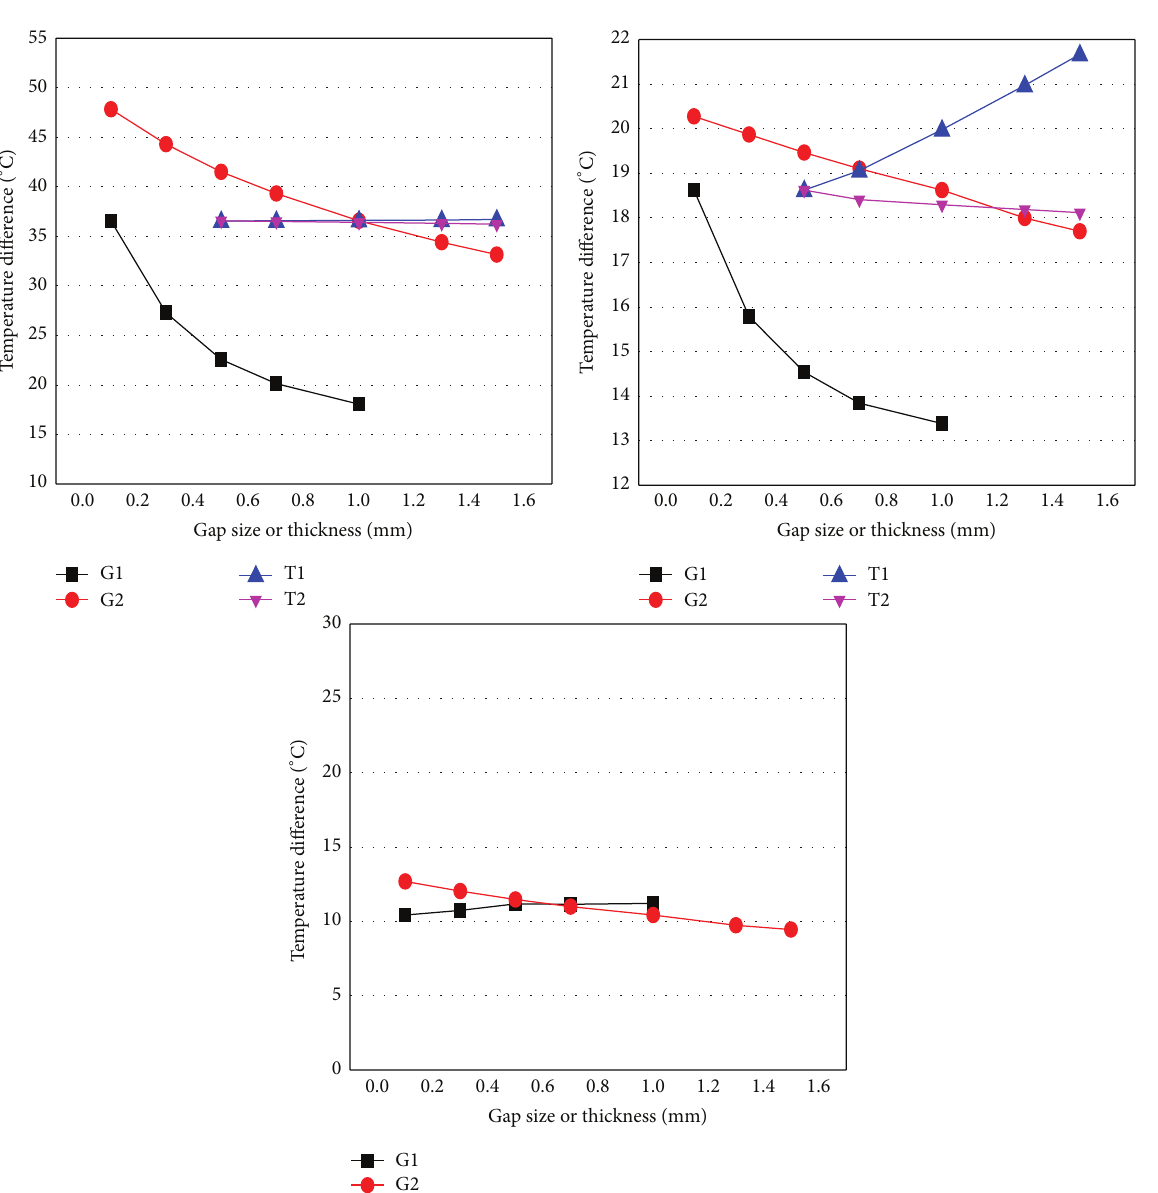
Figure 8: Effects of gaps G1 and G2 and container’s thicknesses T1 and T2 on the temperature difference within the specimen (from left: NaK/LBE/aluminum thermal